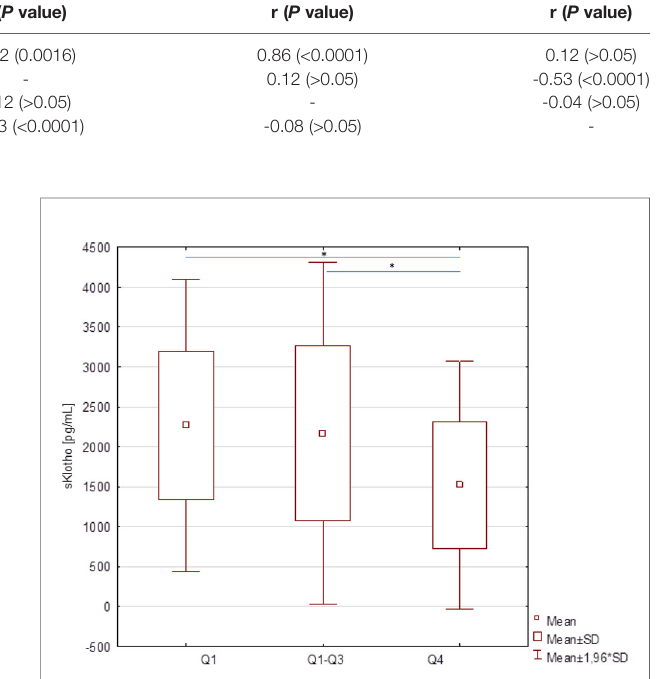
FIGURE 1 | Concentrations of sKlotho protein in children with type 1 diabetes according to the HbA1c level quartile (Q1 – quartile 1, Q1-3 – quartile 1-3, Q4 – quartile 4; * marks statistically signi fi cantly